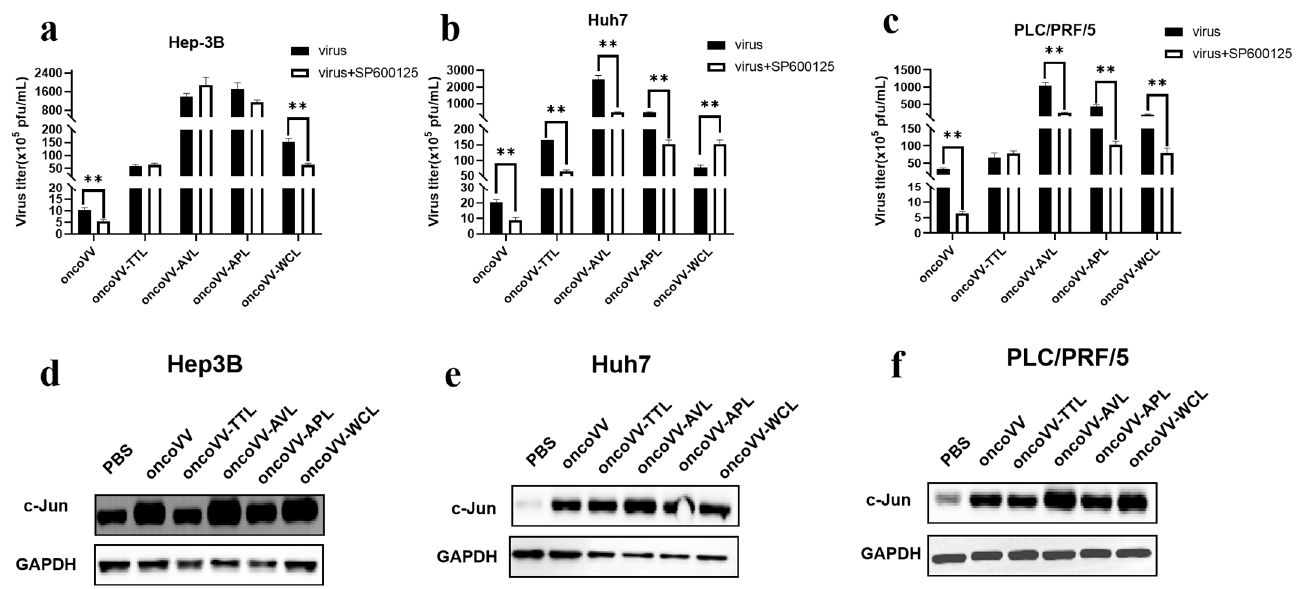
Figure 6. Relationships between JNK pathway and virus replication in HCC. ( a – c ) Virus titers in HCC treated with SP600125 (** p < 0.01). Hep-3B, Huh7, and PLC/PRF/5 cells were maintained for